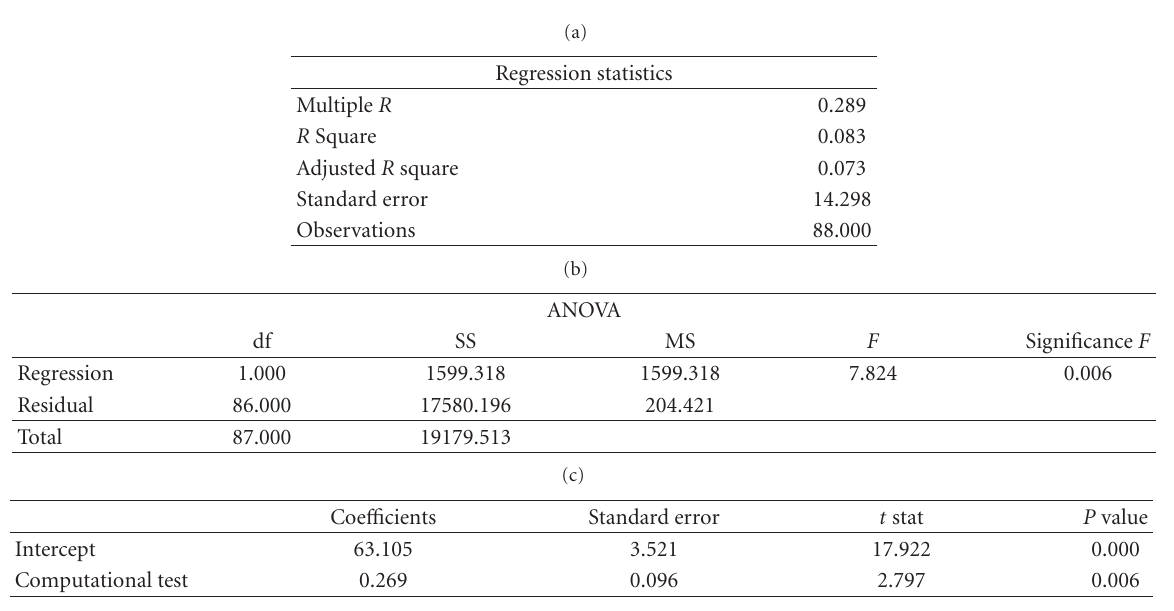
Table 2: Tool recognition versus computational test.